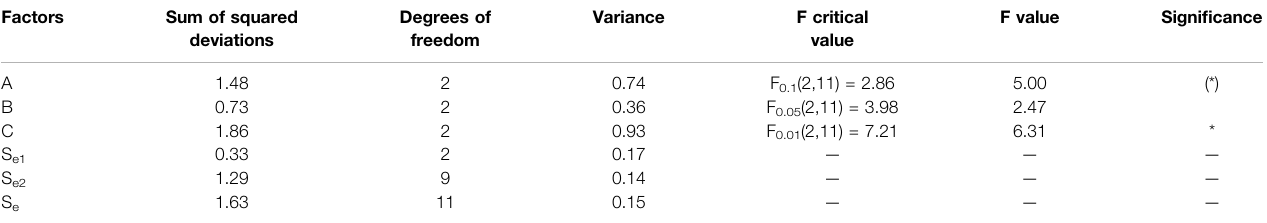
TABLE 8 | Analysis of variance for the ultimate tensile stress test. Factors